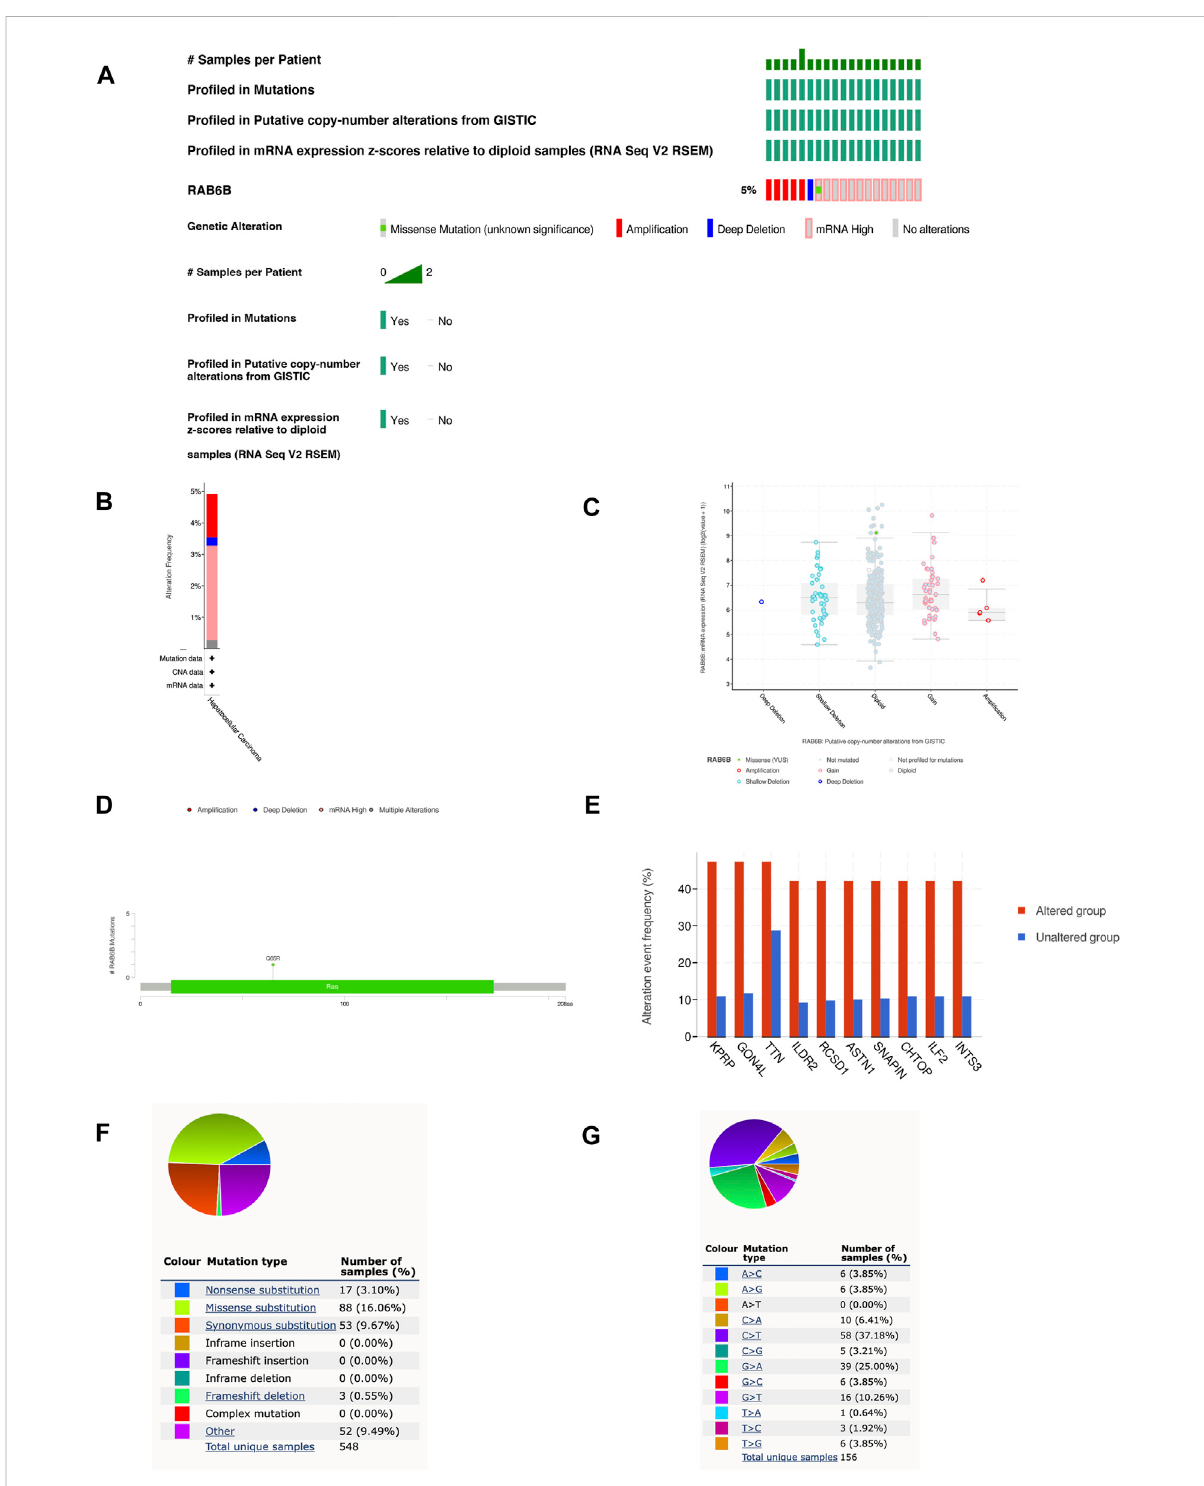
FIGURE 3 RAB6B mutation landscape in HCC. (A) OncoPrint summarized the genetic alterations in RAB6B based on LIHC (TCGA, Firehose Legacy, 379 samples) from the cBioPortal database. (B) RAB6B mutation frequency in HCC according to TCGA data. (C) The dot plot showed the correlation between RAB6B copy number and mRNA expression by cBioPortal. (D) Mutation diagram of RAB6B in HCC across protein domains. (E) The histogram showed the top 10 genes with the highest frequency in the genetic altered and unaltered group. (F,G) The pie chart showed the proportion of various mutation types of RAB6B in HCC based on the COSMIC